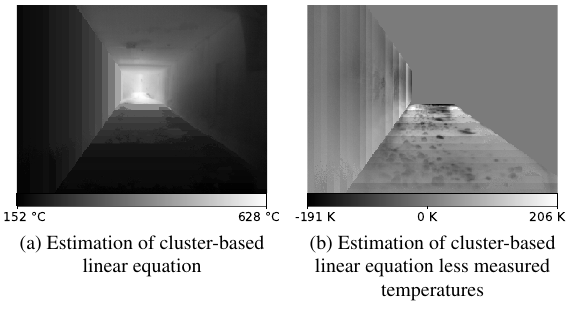
Figure 9. Results of cluster-based tree bagger.